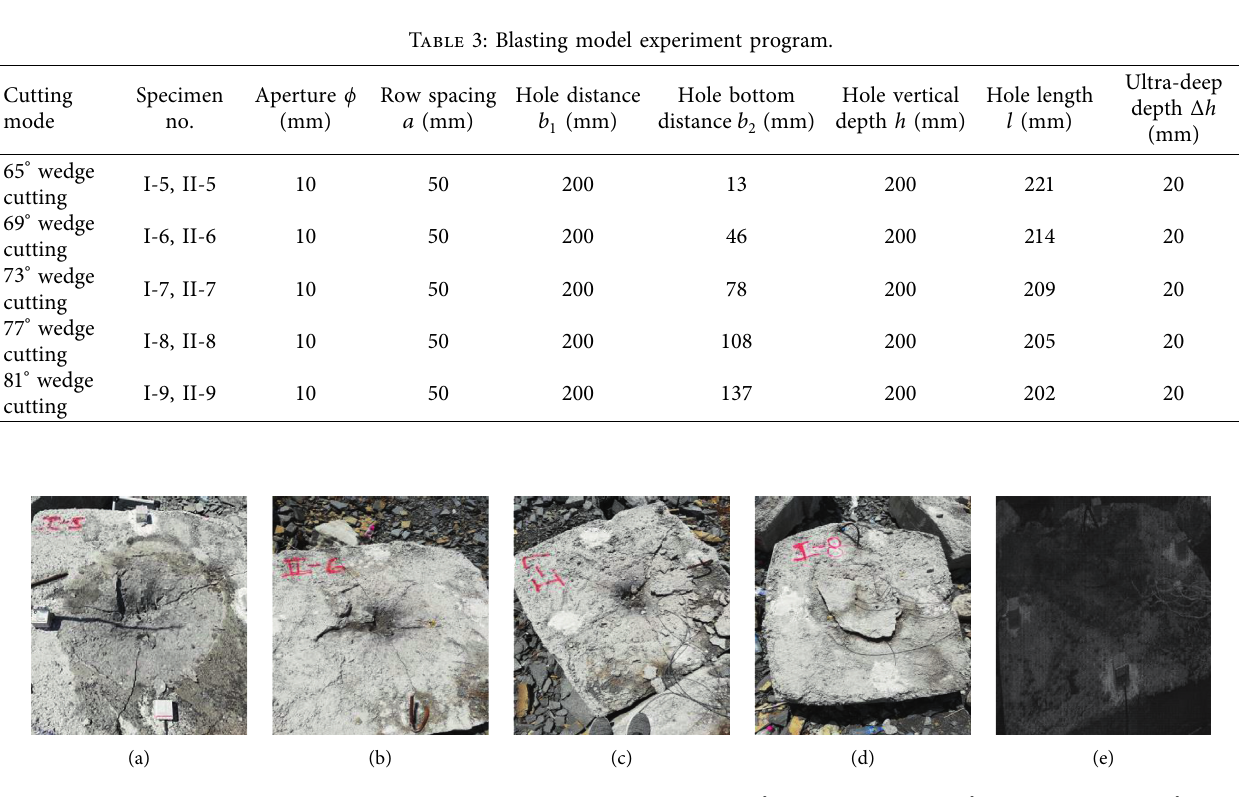
Figure 5: Experiment results of wedge cutting blasting with different angles. (a) 65 ° wedge cutting, (b) 69 ° wedge cutting, (c) 73 ° wedge cutting, (d) 77 ° wedge cutting, and (e) 81 ° wedge